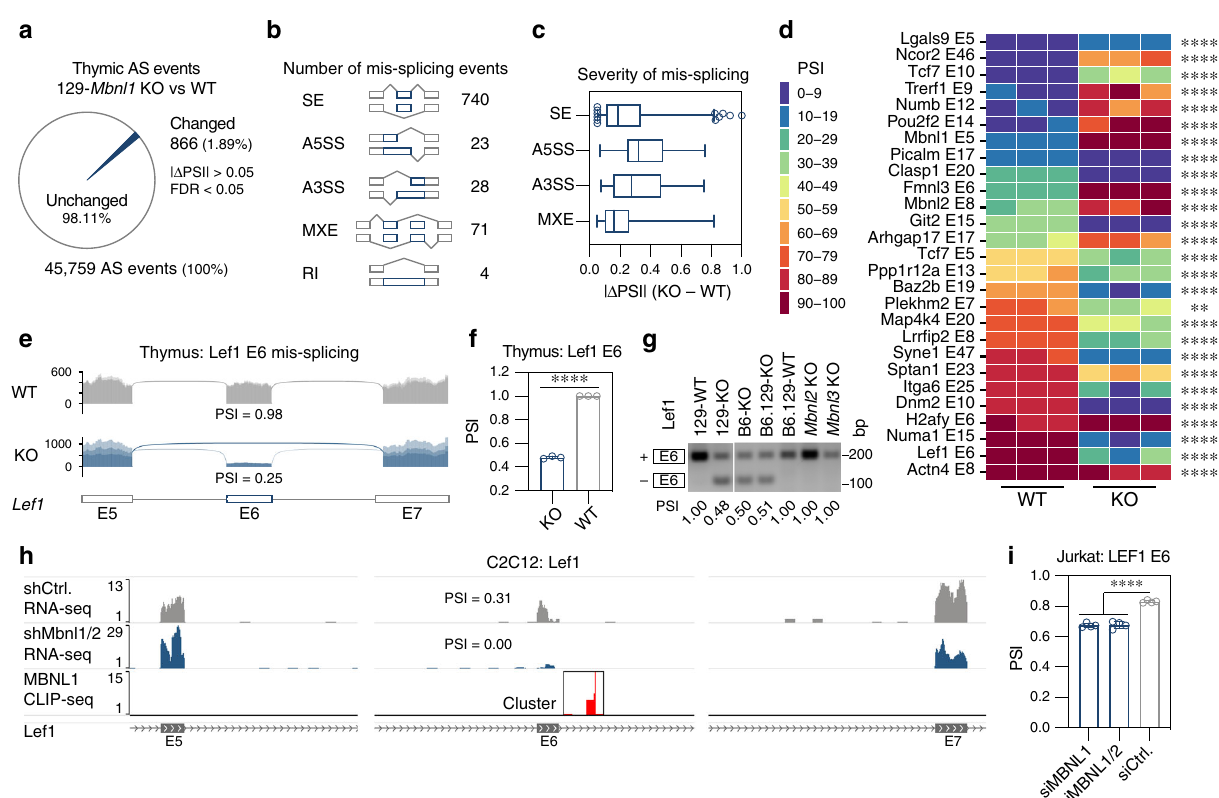
Fig. 3 Alternative splicing changes in Mbnl1 KO thymus. a Alternative splicing (AS) changes in 129- Mbnl1 KO thymus. Pie chart represents the proportion of signi fi cantly altered AS events (blue) to all detected AS events (gray) in the 129- Mbnl1 KO ( n = 3) compared to WT ( n = 3). b Number of signi fi cantly changed AS events categorized as skipped exons (SE), alternative 5 ′ and 3 ′ splice sites (A5SS and A3SS), mutually exclusive exons (MXE) and retained introns (RI). c Wide range of splicing changes. Box plot of AS event| Δ PSI | values. PSI — percent spliced in. Center line represents the median, and the box extends from the 25th to 75th percentiles. Whiskers show 1 – 99 percentile. d Heat map illustrates selected 27 AS events changed in Mbnl1 KO thymus (compare to Fig. 5e). ** FDR < 0.01, **** FDR < 0.0001. e Sashimi plot of Mbnl1 KO ( n = 3) and WT ( n = 3) RNA-seq samples for Lef1 E5-E6-E7. Mean PSI values are provided below the plots. f Lef1 E6 exclusion in 129- Mbnl1 KO ( n = 3) compared to WT ( n = 3) thymi detected by RT-PCR. Bar graph shows mean PSI ± SD. Signi fi cant difference was determined by the two-tailed t-test: **** P < 0.0001. g Representative gel of Lef1 E6 RT-PCR assay from the different Mbnl1 KO strains as well as Mbnl2 and Mbnl3 KOs. PSI values are provided below each gel lane. h Genome browser view of RNA-seq generated from C2C12 cells with the compound Mbnl1 and Mbnl2 knockdown by shRNA. The cluster of MBNL1 CLIP-seq reads indicates MBNL1 binding sites in C2C12. i MBNL1 ( n = 4) as well as compound MBNL1 and MBNL2 ( n = 4) knockdown causes LEF1 E6 exclusion in human T cells (Jurkat). Bar graph shows mean PSI ± SD. Signi fi cant difference was determined by Dunnett ’ s multiple comparison test: **** adjusted P value ( P adj ) < 0.0001. Source data are provided as the Supplementary Data 1 and Source Data fi